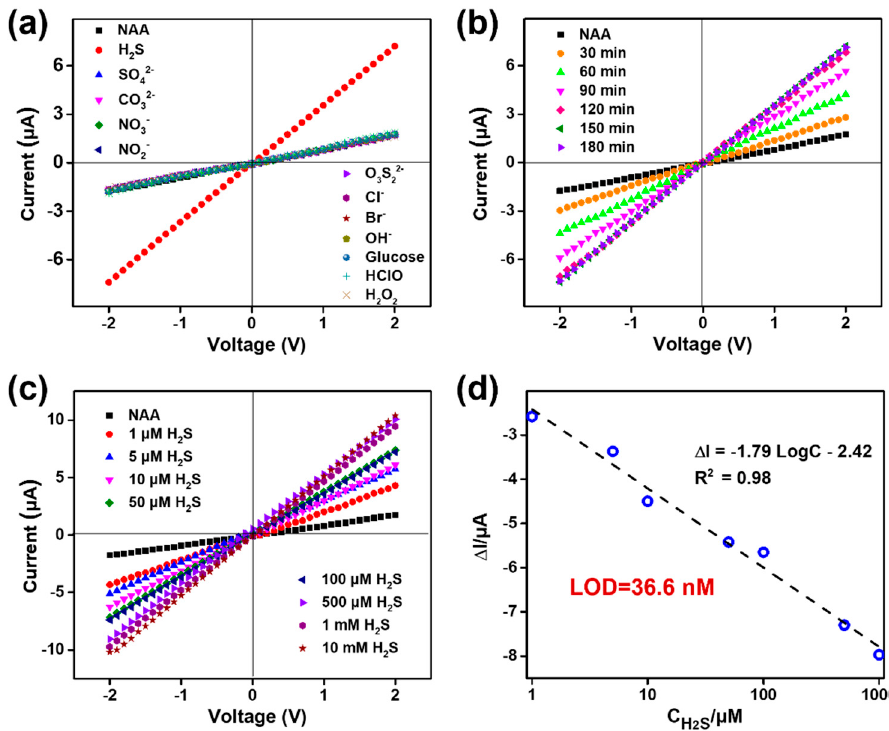
Figure 4. Response performance of NAA–modified nanochannels towards H 2 S including selectiv- ity from various anion or oxidizers, reaction equilibrium time, and sensitivity using I-V